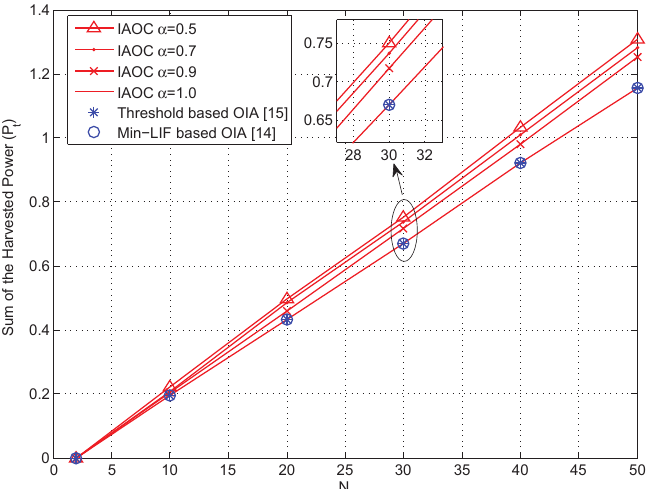
Figure 4. The total harvested power versus N . K = 3, N r = 3, N t = 2, S =